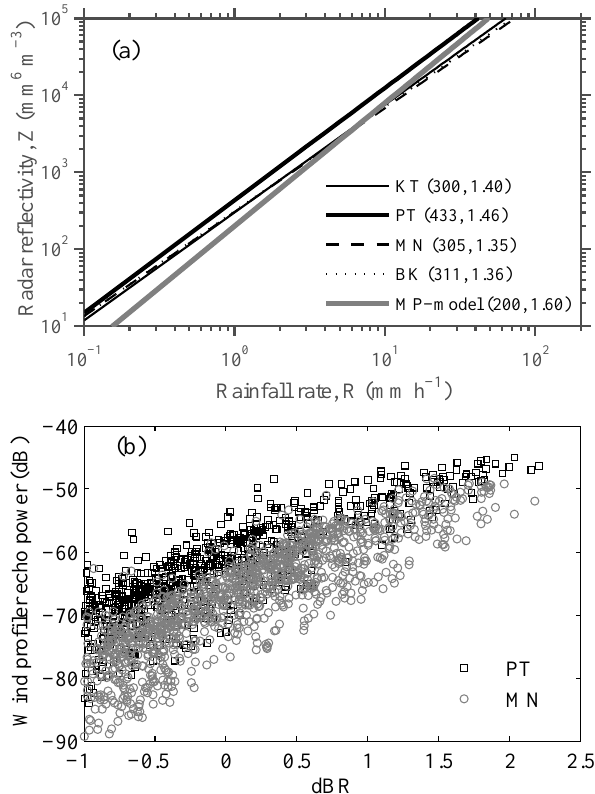
Fig. 5. (a) Z – R relations for the four sites along with Marshall– Palmer relation. The values in the parentheses of the legend denote the value of A and b of Z = AR b , and (b) scatterplot of wind pro- filer vertical beam echo power (dB) at 1kma.s.l. vs. rainfall rate in logarithmic scale (dBR) for PT and MN when the Parsivel detected